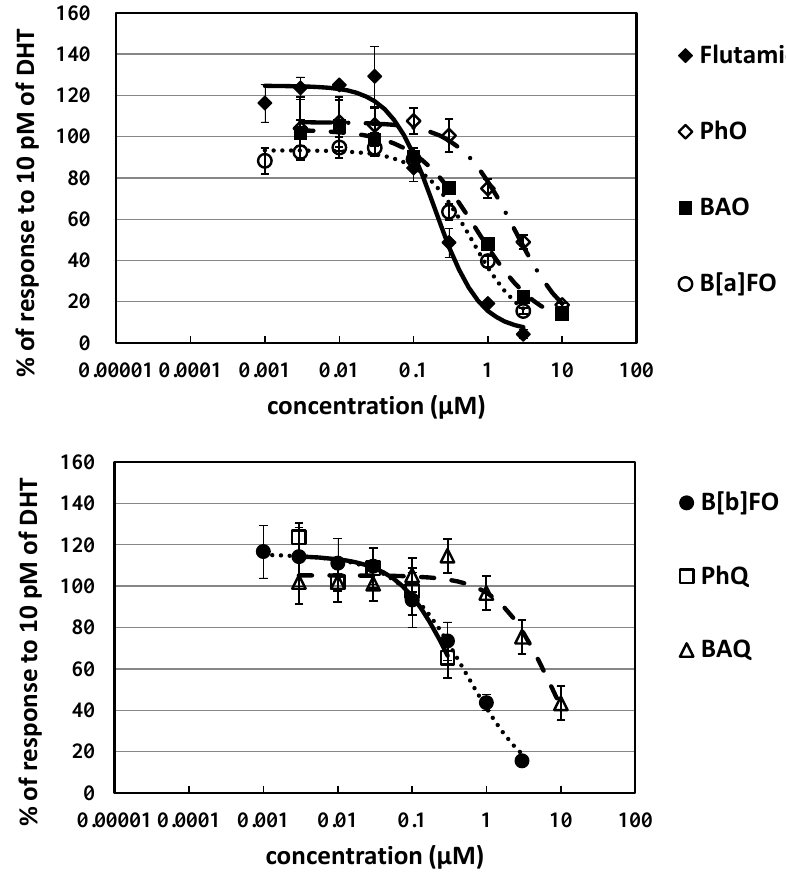
Figure 2. Dose–response curves of antiandrogenic activities for oxy-PAHs in 24 h exposure experi- ments with the AR-CALUX assay.